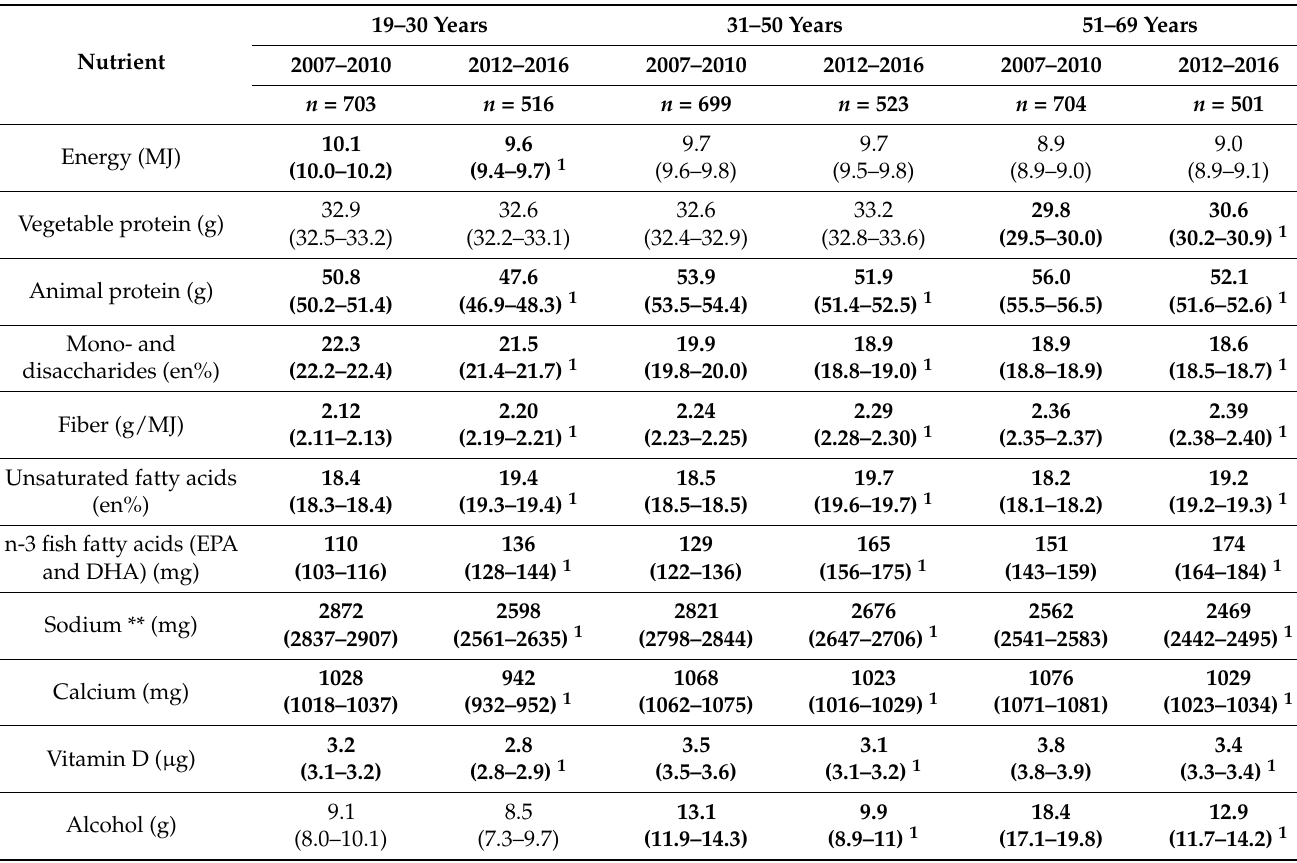
Table 6. Habitual mean ¥ (95%CI) * nutrient intake per day from food sources only for Dutch adults aged 19–69 years in